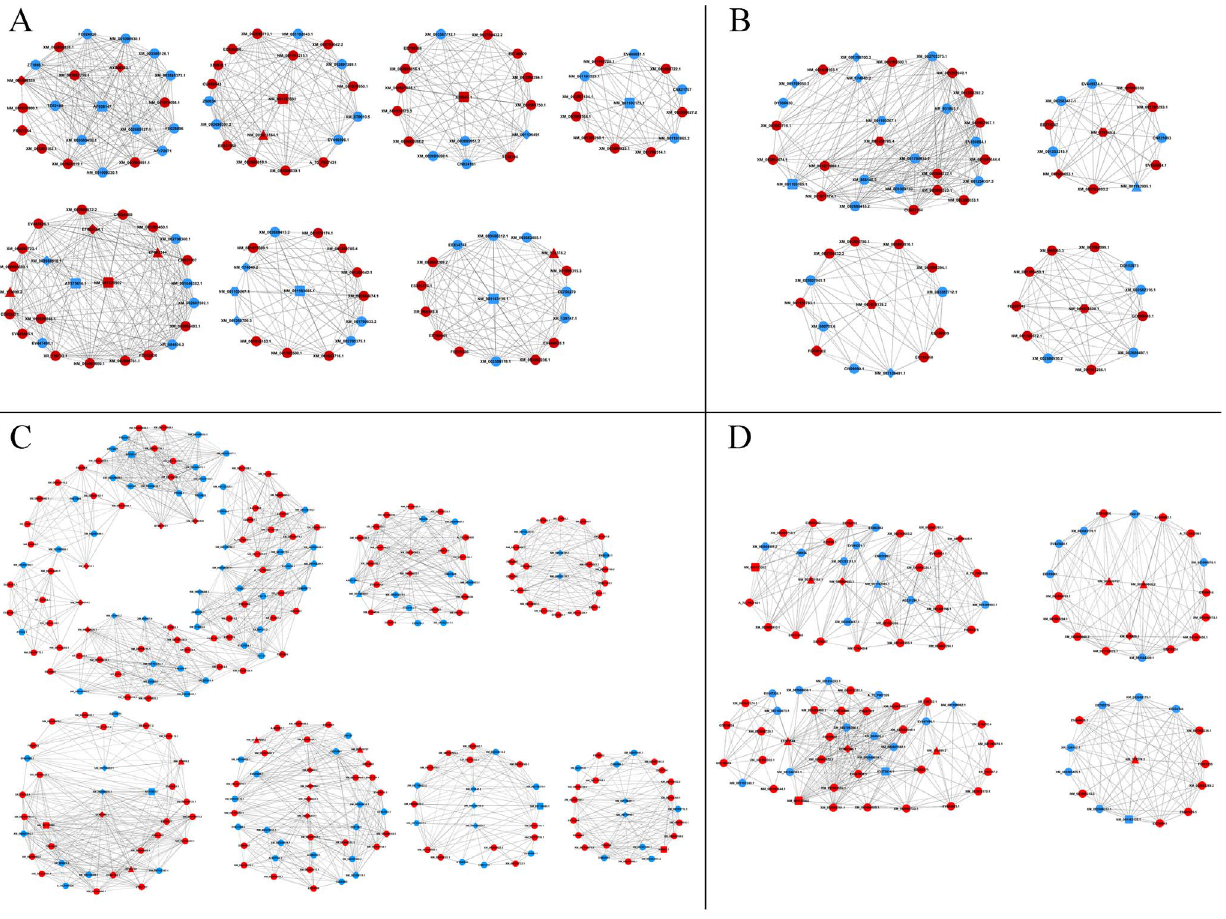
Figure 4. Co-expression network for k-core genes in liver of HC goats. Co-expression networks were for immune and inflammatory responses (A), lipid metabolism (B), protein (or amino acid) metabolism (C), and carbohydrate metabolism (D) in the liver of HC goats. Circles in the figure represent genes (red circle means up–regulation; blue circle means down-regulation), lines represent regulation relationships between genes (solid lines mean a positive correlation of the expression between genes; dotted lines mean a negative correlation), rectangles represent genes for immunity and stress, triangles represent carbohydrate metabolism, hexagons represent lipid metabolism, and diamonds represent protein metabolism.